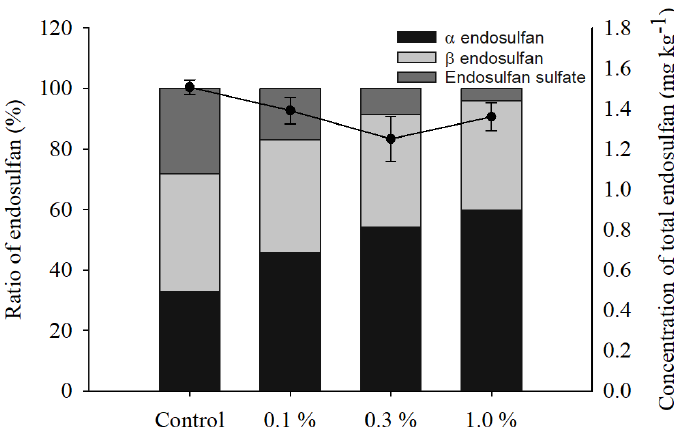
Figure 5. Comparison of the residues of endosulfan at 66 days by biochar treatment.